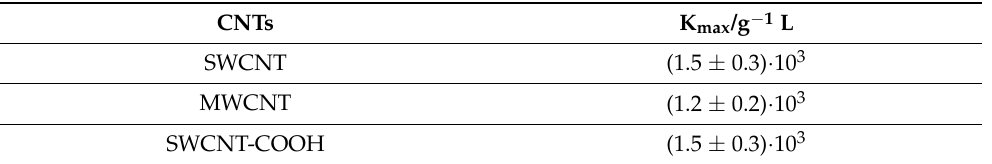
Table 2. Values of K max obtained by fitting the I/I p data shown in Figure 4 using Equations (5)–(7). T = 298.0 ± 0.1